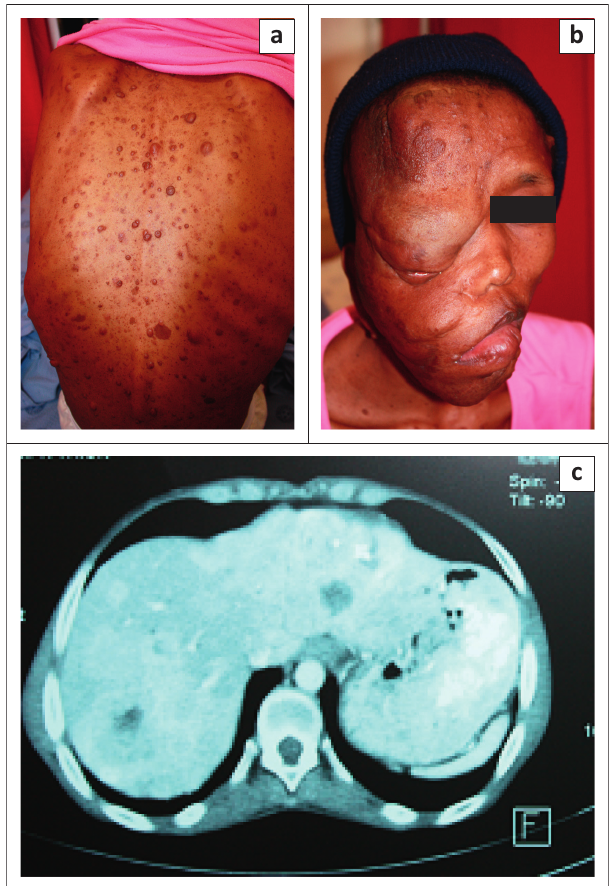
FIGURE 1: Clinical features of NF 1, with numerous neurofibromata (a), big plexiform neurofibroma over the right side of the face (b) and (c) CT image showing several hypodense lesions in the liver parenchyma, suggestive of metastases.